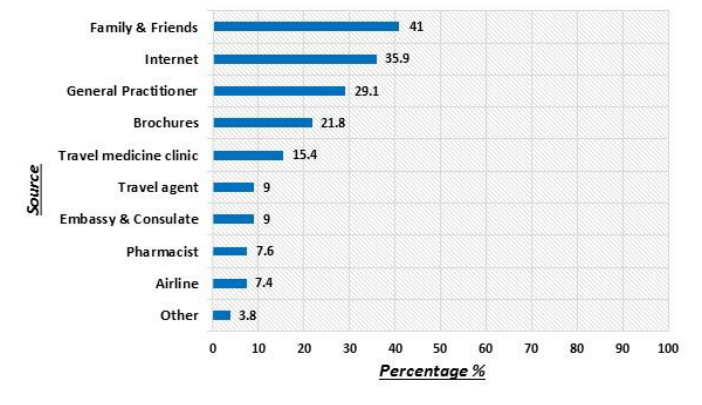
Figure 2. Source of travel health advice for those who sought it. The respondants were permitted to chose more than one option. Only 15.4% depended on travel medicine clinics